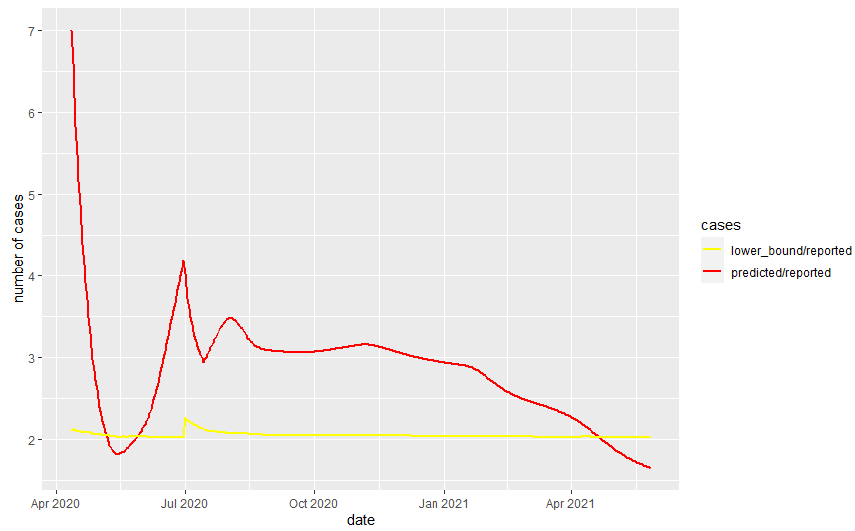
Figure 2. Ratio between number of cases for proposed methods and reported cases. Table 1. Number of cases for some dates.